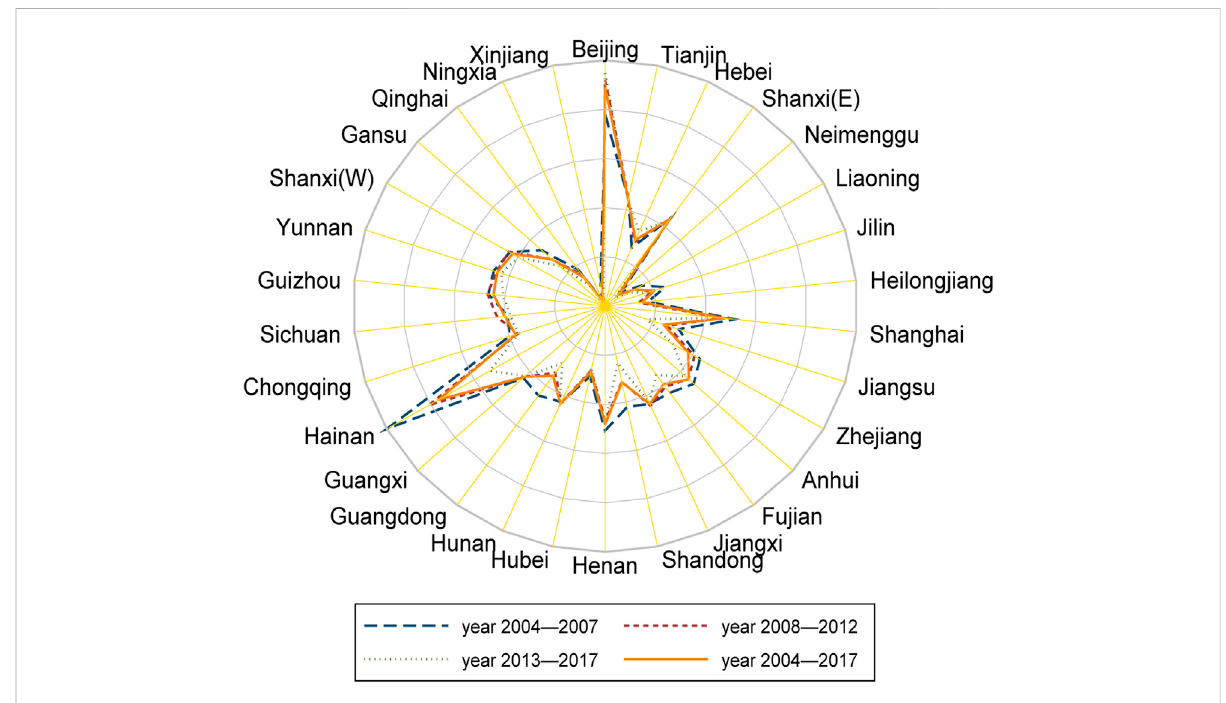
FIGURE 1 The average EWP values of provincial capital cities in China from 2004 to 2017.